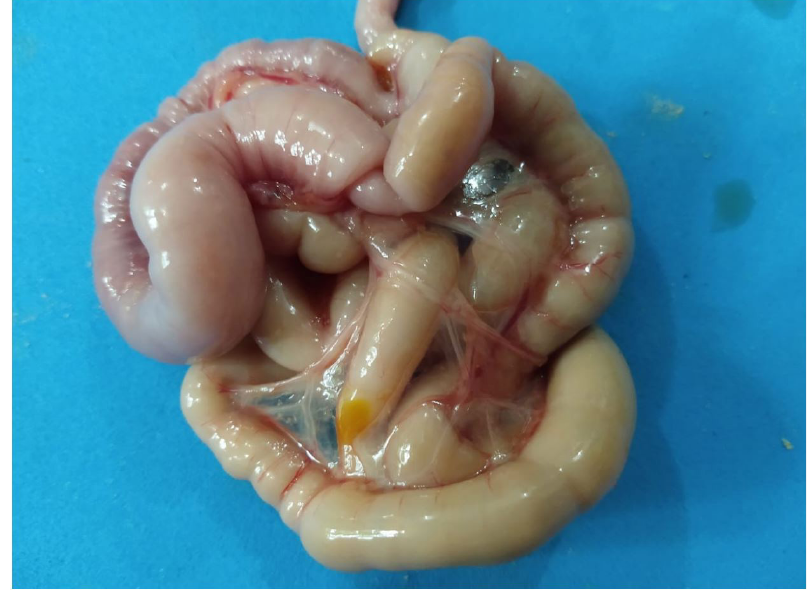
Figure 1. Macroscopic aspect of the small intestine (duodenum, jejunum and ileum) of the patient before undoing the ileal-intussusception observing the presence of invagination of part of the ileum to the intestinal loops of adjacent segments of the ileum